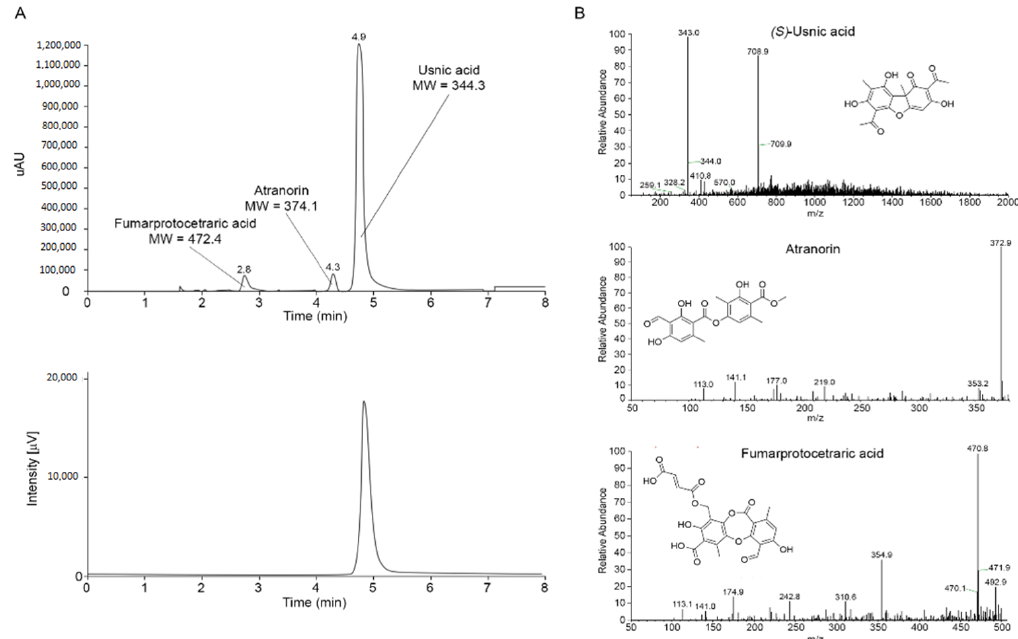
Figure 5. ( A ) HPLC-PAD profile of the crude acetone extract of C. foliacea recorded at λ = 254 nm (above) and the corresponding HPLC-CD profile recorded at λ = 270 nm (below); ( B ) ESI-MS spectra of the peaks at 4.9, 4.3, and 2.8 min and ascribable to UA, atranorin, and fumarprotocetraric acid,